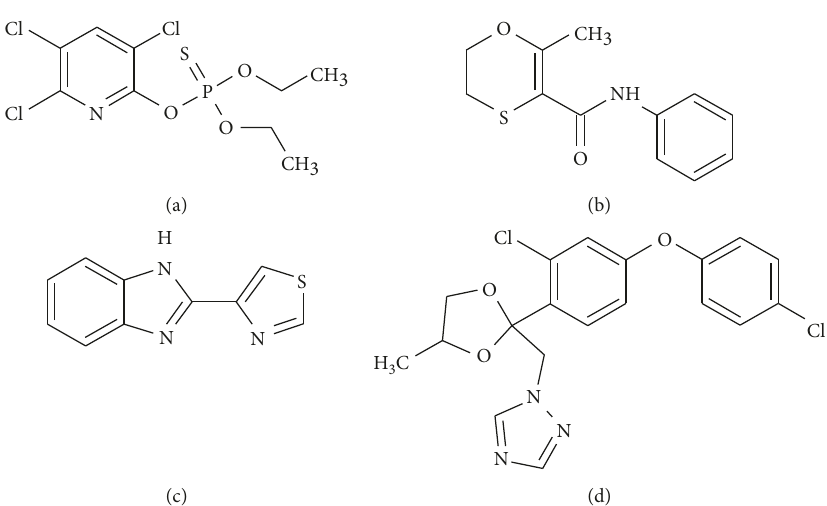
Figure 1: Chemical structures of pesticides: (a) chlorpyrifos, (b) carboxin, (c) thiabendazole, and (d) difenoconazole.